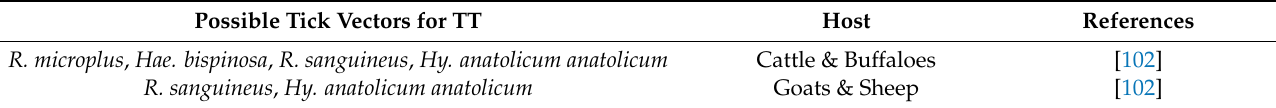
Table 8. Common tick species in different hosts in Bangladesh. Possible Tick Vectors for